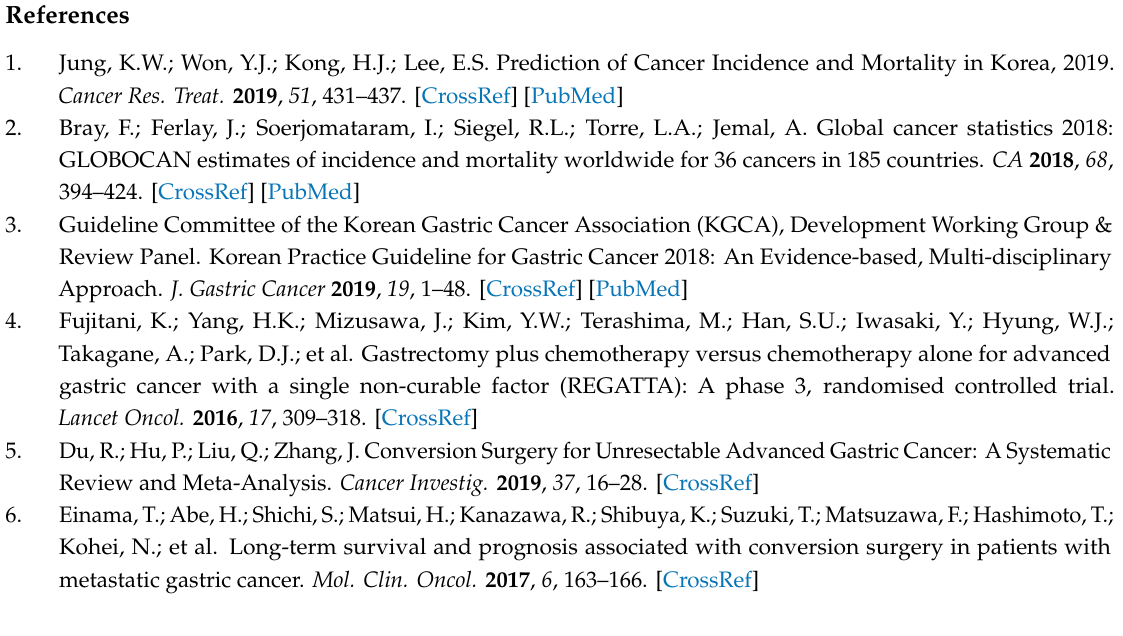
Figure S1: DFS from conversion surgery with R0 resection according to cancer dormancy marker expression, Table S1: The characteristics and clinical course of patients who received noncurative resection with conversion